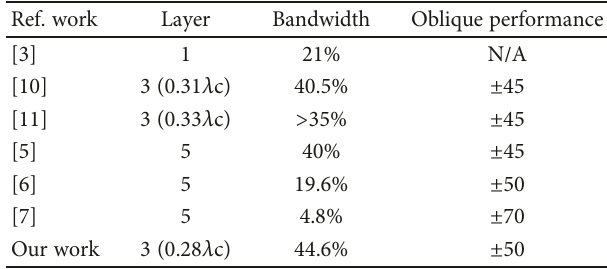
Table 3: Comparisons between the proposed structure and some other reported linear-to-circular